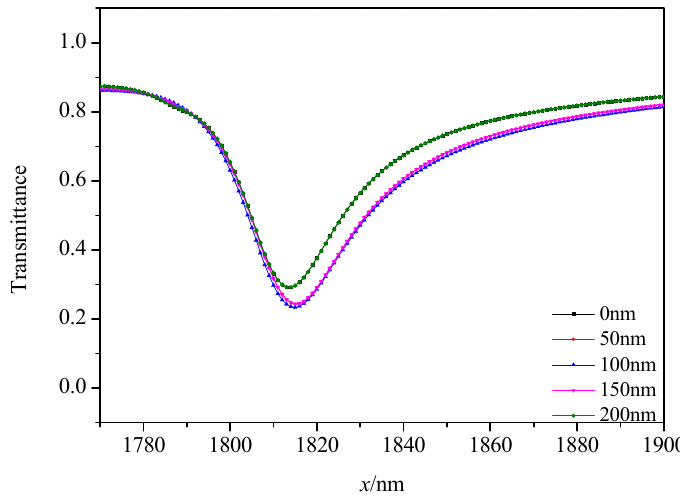
Figure 4. Transmission spectra of different displacements of the ring from the stub x .